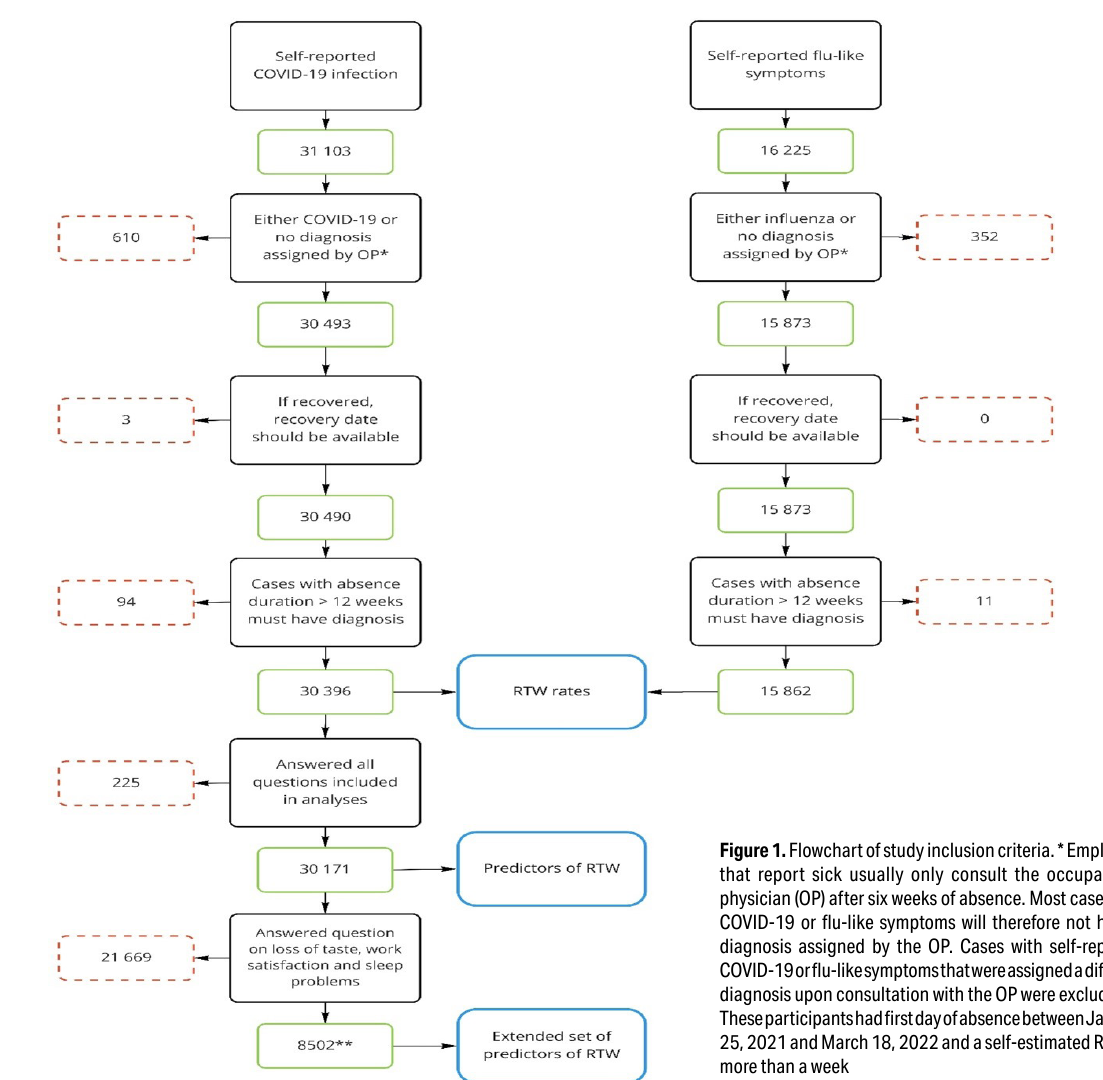
Figure 1. Flowchart of study inclusion criteria. * Employees that report sick usually only consult the occupational physician (OP) after six weeks of absence. Most cases with COVID-19 or flu-like symptoms will therefore not have a diagnosis assigned by the OP. Cases with self-reported COVID-19 or flu-like symptoms that were assigned a different diagnosis upon consultation with the OP were excluded. ** These participants had first day of absence between January 25, 2021 and March 18, 2022 and a self-estimated RTW of more than a